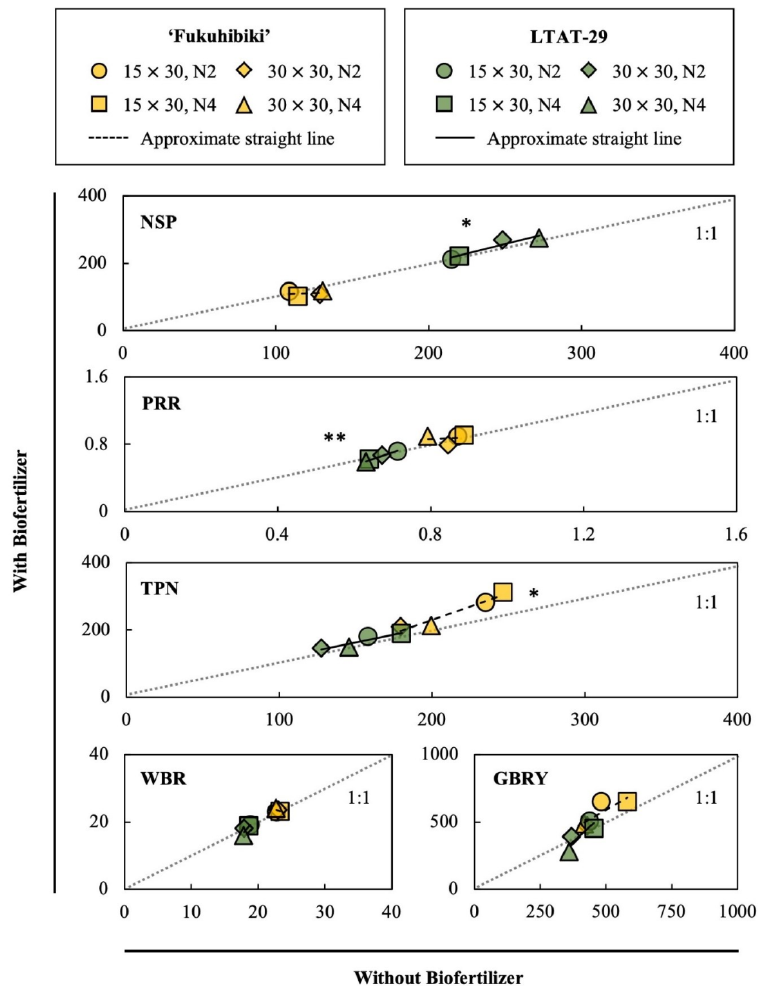
Figure 4. Scatter plots of the yield components of feed rice cv. ‘Fukuhibiki’ and line LTAT-29. The vertical bar of each scatter plot box indicates the value of the inoculated biofertilizer. The horizontal bar of each scatter plot box indicates the values for the non-inoculated plants. The yellow box plots show the values of ‘Fukuhibiki’, and the approximately straight lines of ‘Fukuhibiki’ are indicated by dotted lines. The plots of the green circles show the values of LTAT-29, and the approximate straight lines of LTAT-29 are indicated by black lines. Gray dotted lines 1:1 correspondence. NSP: Number of spikelets in a panicle, PRR: Percentage of ripened rice seeds to the total number of seeds, WBR: Weight of one thousand gross brown rice, TPN: Total panicle number in a square meter, GBRY: Gross brown rice yield in 100 square meters (kg). * and ** indicate significant correlation at p ≤ 0.05 and 0.01 levels, respectively (Pearson’s test,